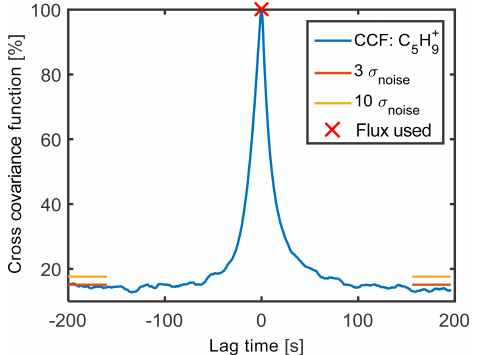
Figure A6. Averaged absolute CCF for C 5 H + over the 10 σ noise criteria.